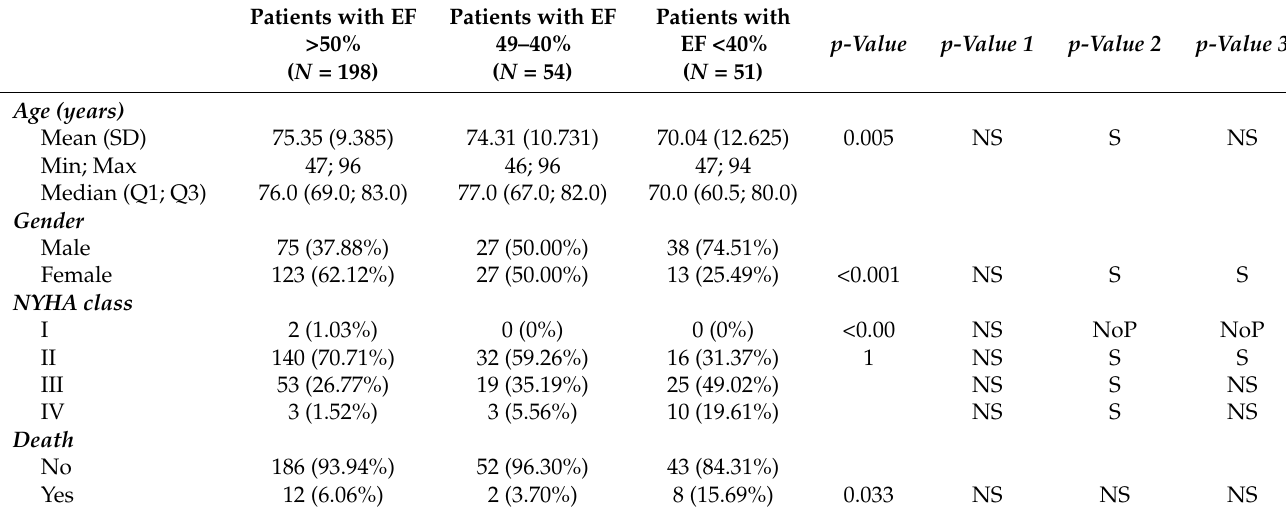
Table 1. Summary of baseline characteristics.